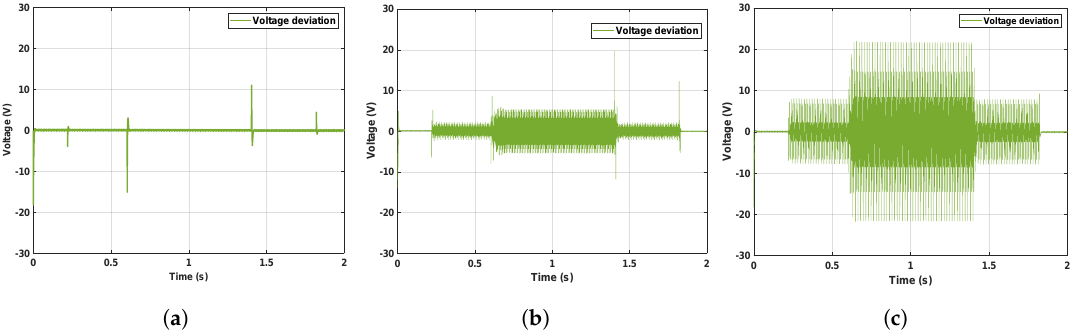
Figure 9. DER system output voltage deviation. ( a ) 100% linear load with HC. ( b ) 100% non-linear load with HC. ( c ) 100% non-linear load without